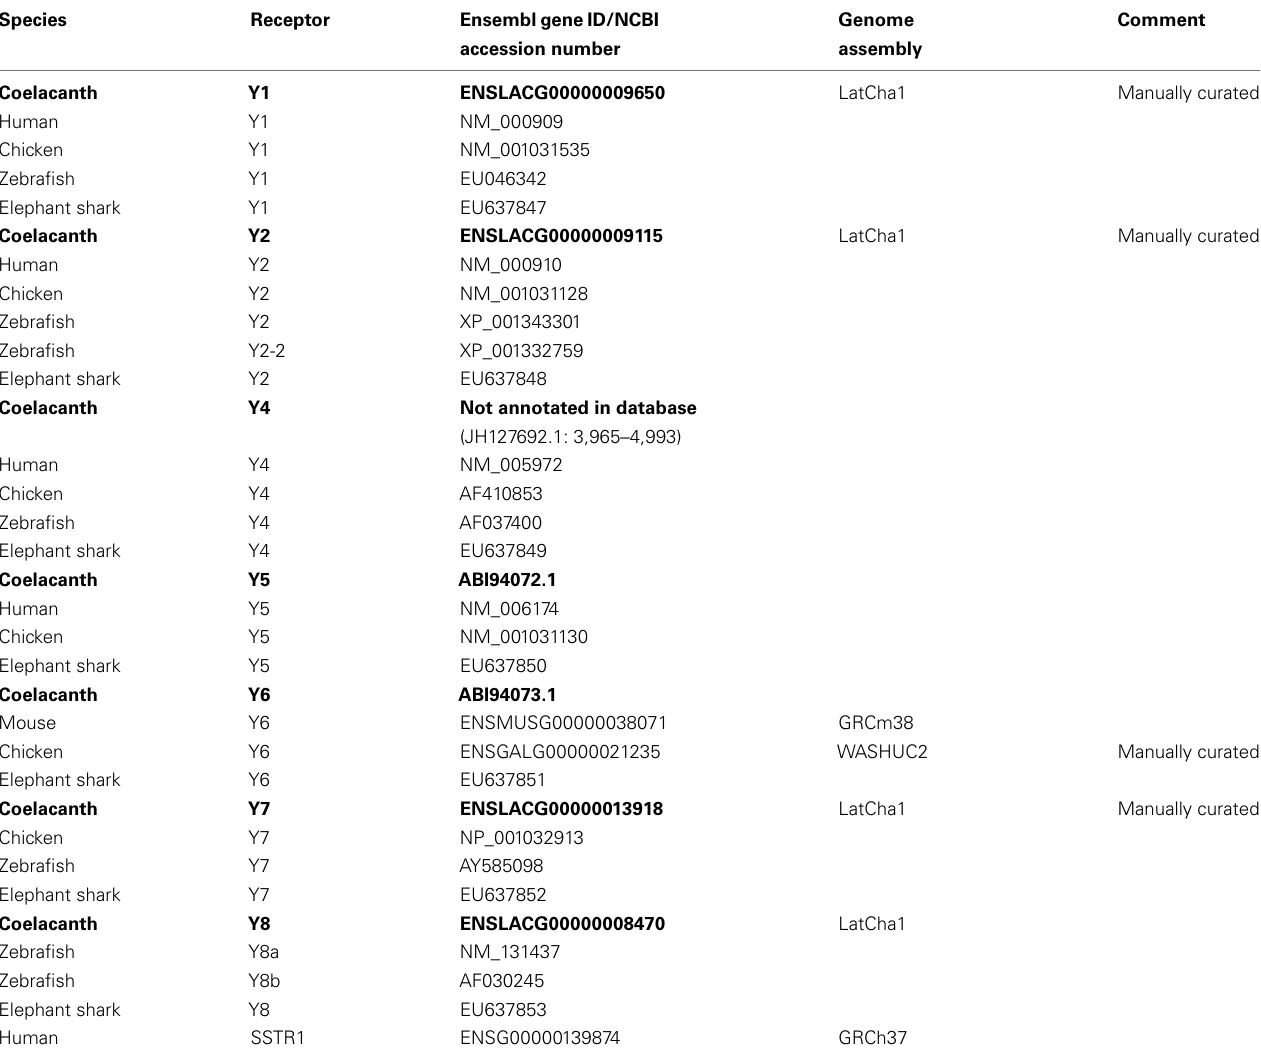
Table 1 |The table lists Ensemble gene ID or NCBI accession number for the coelacanth NPY-family receptor and peptide genes as well as the orthologs genes in human, chicken, zebrafish, and elephant